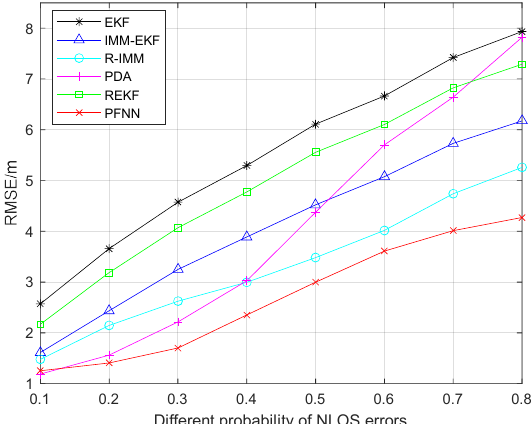
Figure 4. The RMSE versus the probability of the NLOS error.